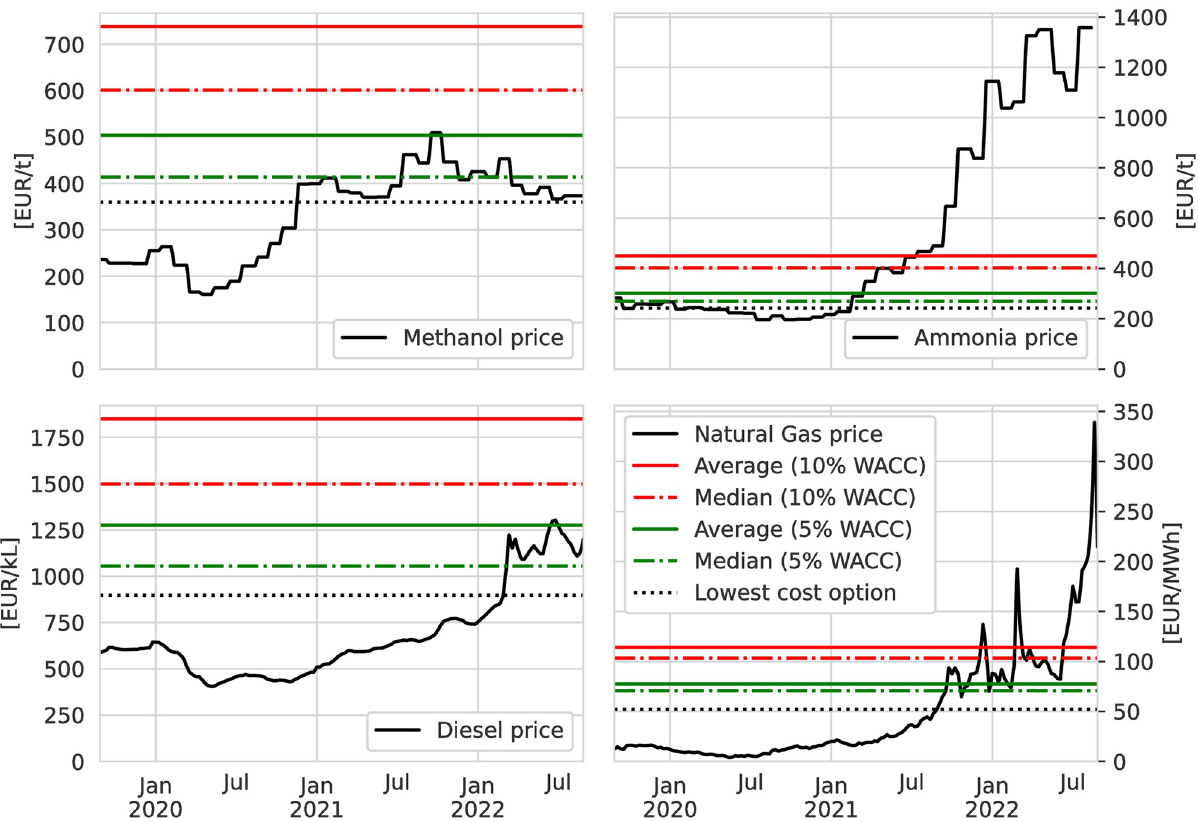
Fig 11. Comparison of market prices of current fossil-based commodities with modelled costs for synthetic ESC-based alternatives. Market prices are for Methanol based on MMSA Europe Spot FOB [31], Ammonia based on German export prices for ammonia [54], Natural gas based on Dutch TTF C1 future [55], FT fuel based on EU Diesel prices without taxes [56]. Statistics for natural gas are based on the costs for the CH 4 pipeline and shipping CH 4 (l) ESCs. The median value thus represents four exporter options for FT fuel, ammonia and methanol. For methane the median value represents eight exporter options.